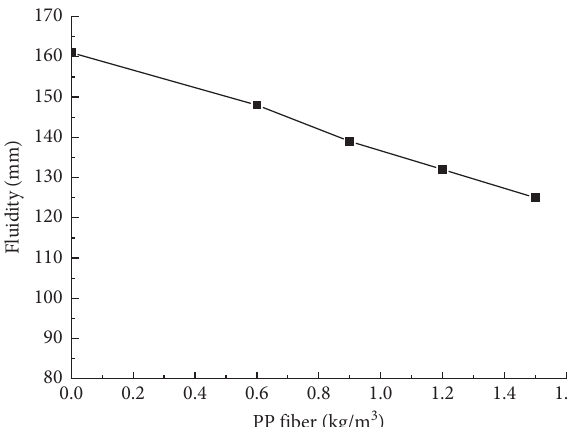
Figure 1: Effect of PP fiber on the fluidity of CGA